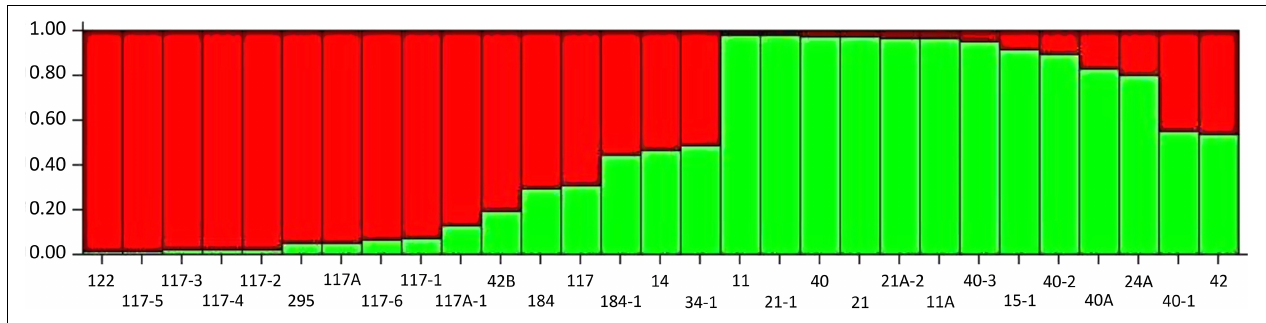
FIGURE 7 | Population grouping of P. graminis f. sp. tritici pathotypes at estimated membership fraction for K = 2 using STRUCTURE. The grouping indicates two different populations in green and red with allele sharing more than 70% and an admixture with allele sharing less than